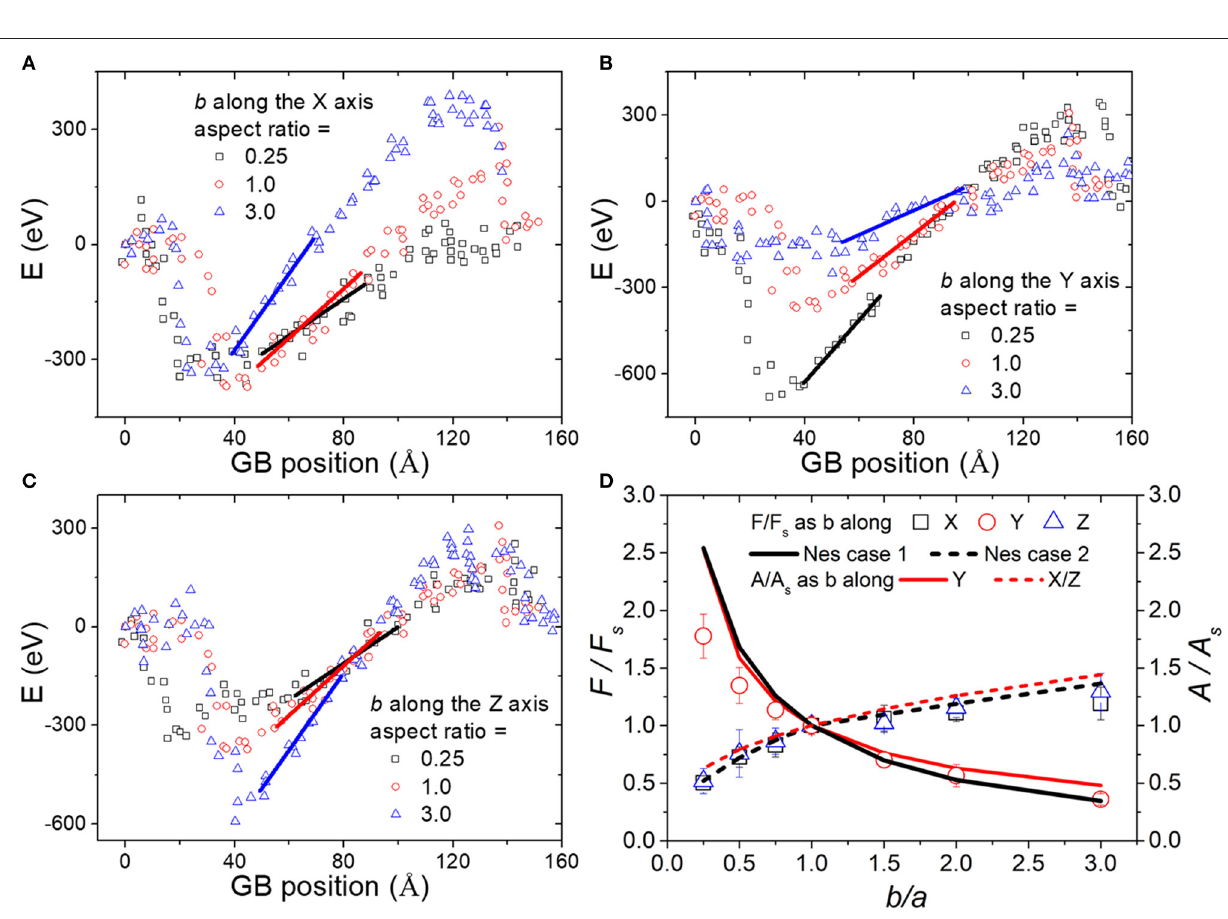
FIGURE 5 | Energy evolution as a function of GB position during the GB–particle interaction for the ellipsoidal particles of different AR values when b is parallel to the (A) X-, (B) Y-, and (c) Z-axes, respectively. In (A–C) , the maximum slope of each curve, corresponding to the maximum pinning force is marked. (D) Maximum pinning force vs. AR for the ellipsoidal particles. Theoretical predictions by Nes et al. (1985) together with the projection area of the particles to the plane normal to the boundary migration direction, i.e., the Y direction, are given for comparison. The maximum pinning force, F , and the area, A , are normalized by the F s and A s of the spherical particle case,